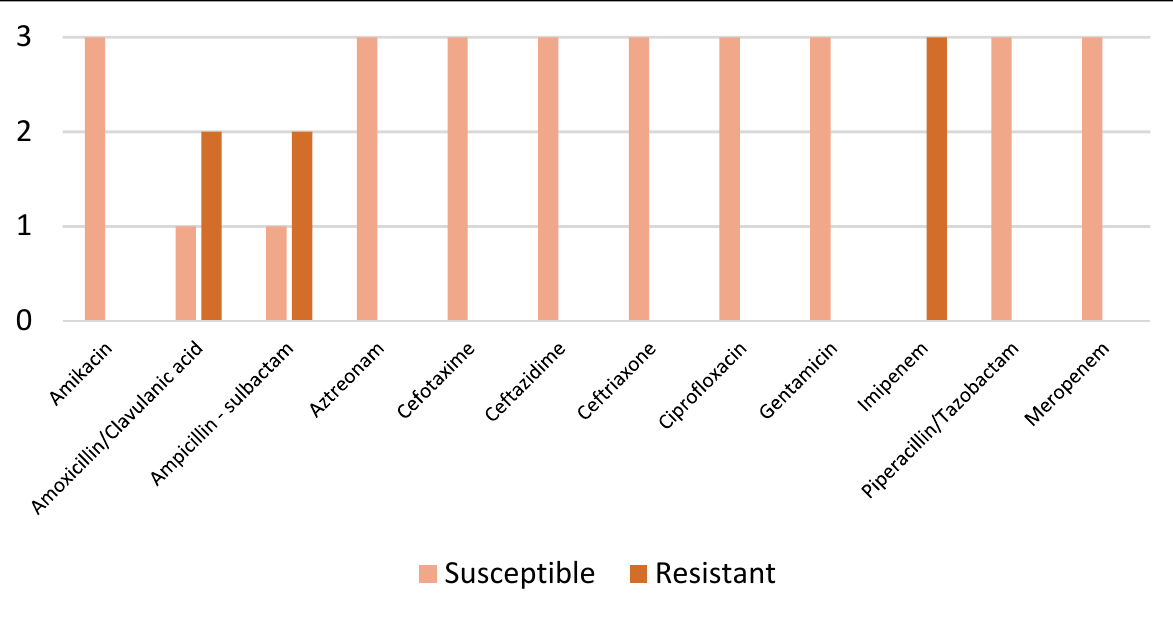
Figure 5. AST results of Proteus mirabilis .